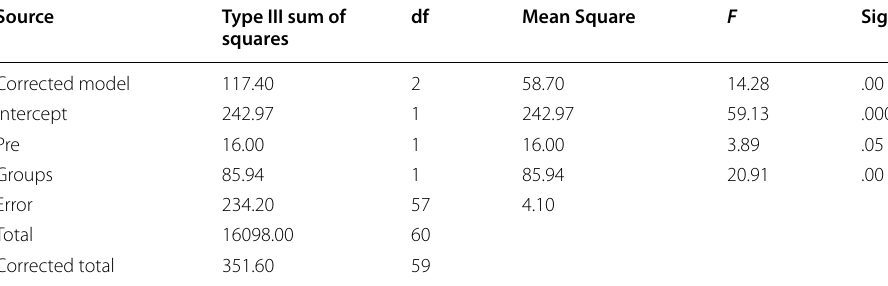
Table 2 One-way ANCOVA (EG and CG VL post-tests)